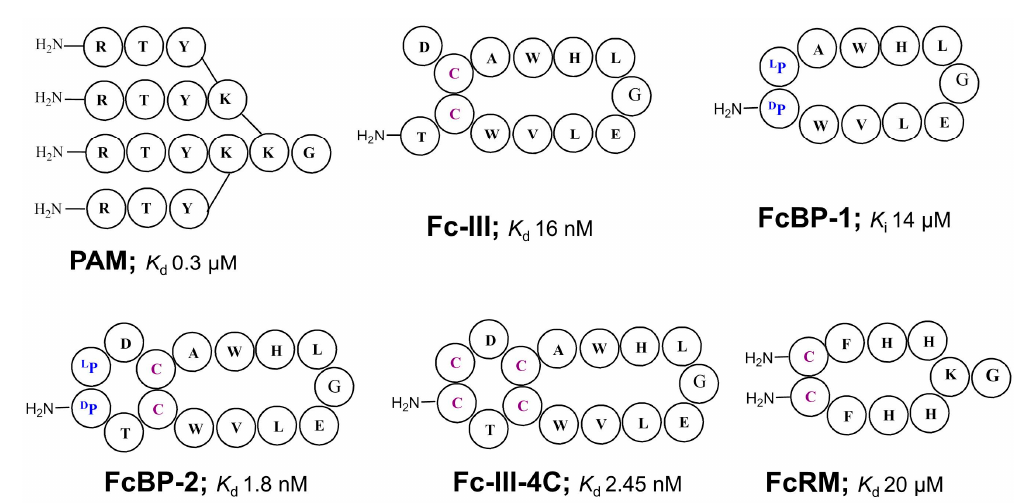
Figure 2. Structures of branched- and cyclic peptide-based high affinity ligands that bind to IgGs through interaction with the Fc-domain. The reported affinity constants are towards IgG. Elution pH of antibody from affinity ligand column: PAM, 3 or 9; Fc-III, 3.5; Fc-III-4C, 3.5; FcRM, 2.7 [42,45,50,51,54].